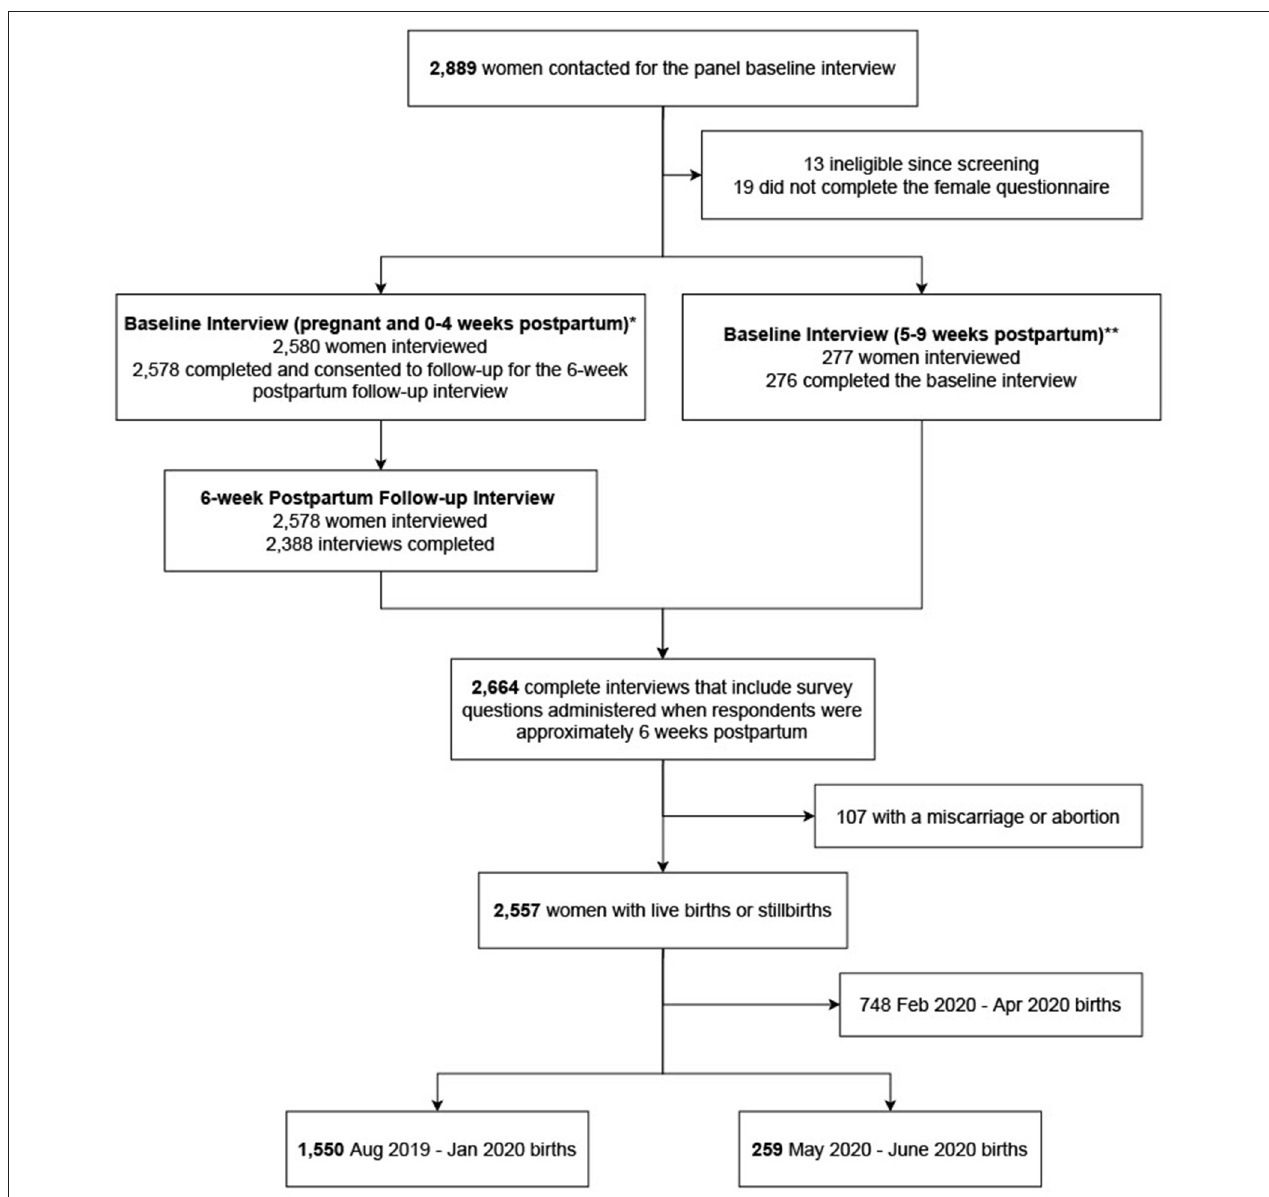
FIGURE 1 | Study cohort diagram. *Women who were pregnant or 0–4 weeks postpartum at the time of the first panel interview received survey questions related to maternal care services they received up to the time of interview. Estimated or actual delivery dates of women were used to schedule a second interview, which was conducted when respondents were about 6 weeks postpartum. Some 6-weeks postpartum interviews were conducted before the COVID-19 pandemic; others were conducted during the COVID pandemic. PMA survey interview questions slightly for interviews conducted during the COVID pandemic. **Women who were 5–9 weeks postpartum at the time of the first panel interview received a combined set of survey questions that other women received during two separate interviews. All of these interviews were conducted before the COVID-19